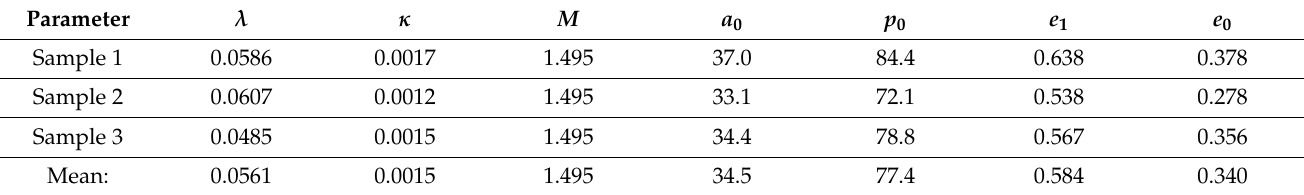
Table 2. A compilation of the output parameters of the Modified Cam-Clay model from laboratory tests.